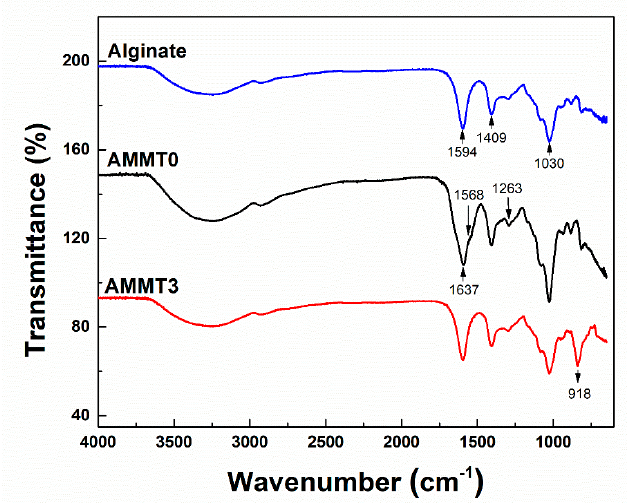
Figure 3. FT-IR spectrum of alginate, AMMT0, and AMMT3 samples. Crosslinking reaction and MMT incorporation were provided by alteration in bands of each specimen.